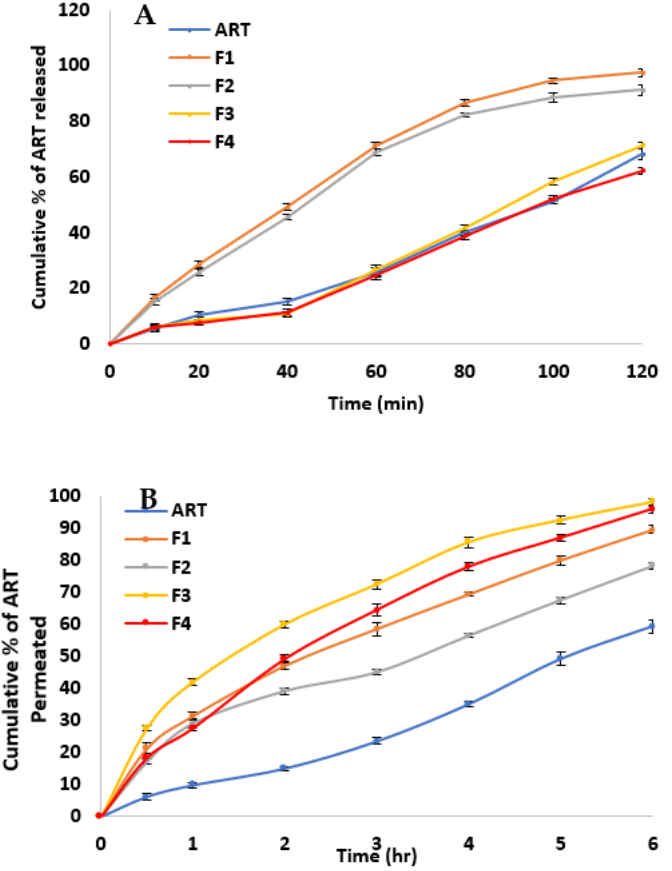
Figure 2. ( A ) Cumulative percentage of ART released in acidic medium and ( B ) Cumulative per- centage of ART permeated through the intestinal mucosa for the prepared SLNs (F1: Poloxamer 407/uncoated—F2: Tween 80/uncoated—F3: Poloxamer 407/chitosan coated—F4: Tween 80/chi- tosan coated).